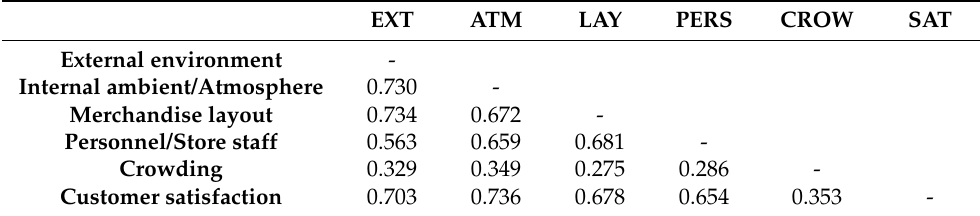
Table 4. Correlations and discriminant validity values (Utilitarian shopping).